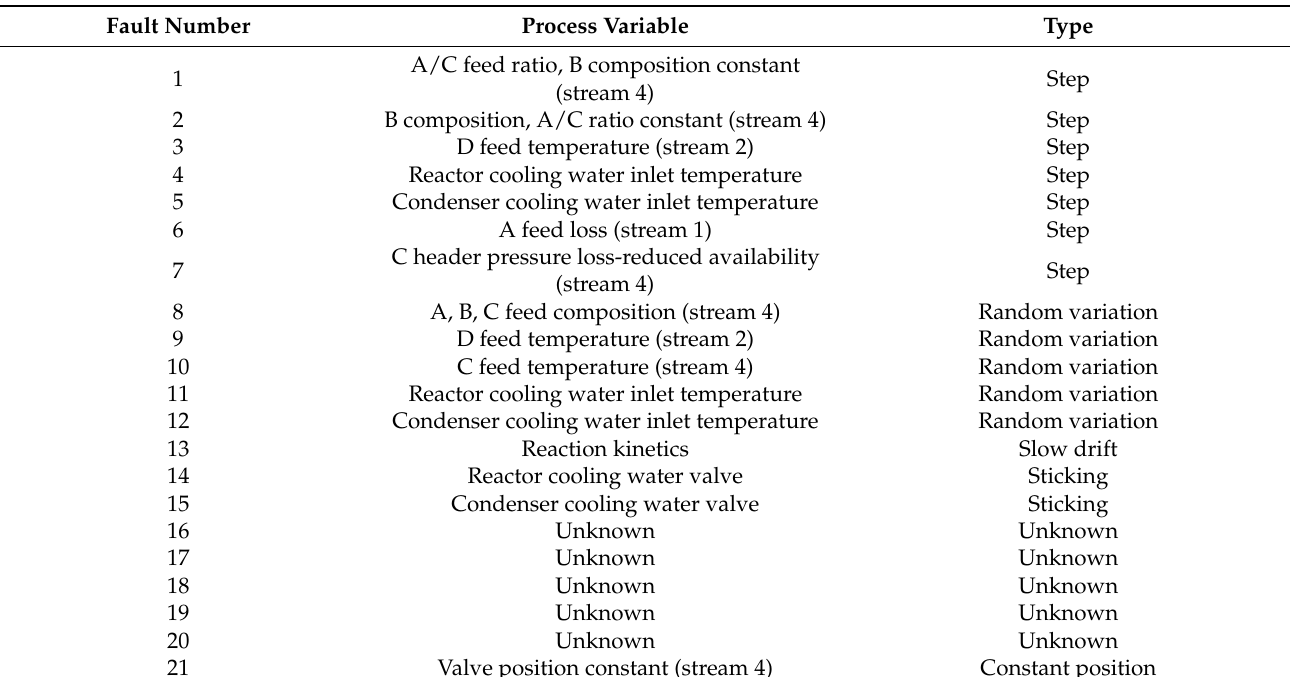
Table 2. Process faults for the TE process.